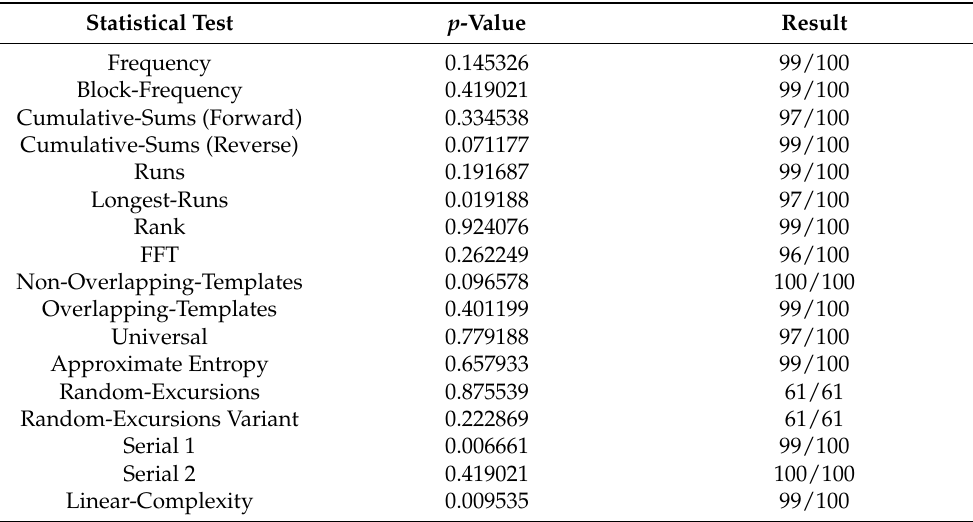
Table 1. STS results for 100 sequences of integers in [ 0,255 ] , each of length 10 6 bits, generated using the chaining rule in Algorithm 2. According to the STS documentation, a minimum pass rate for each statistical test is 96%.